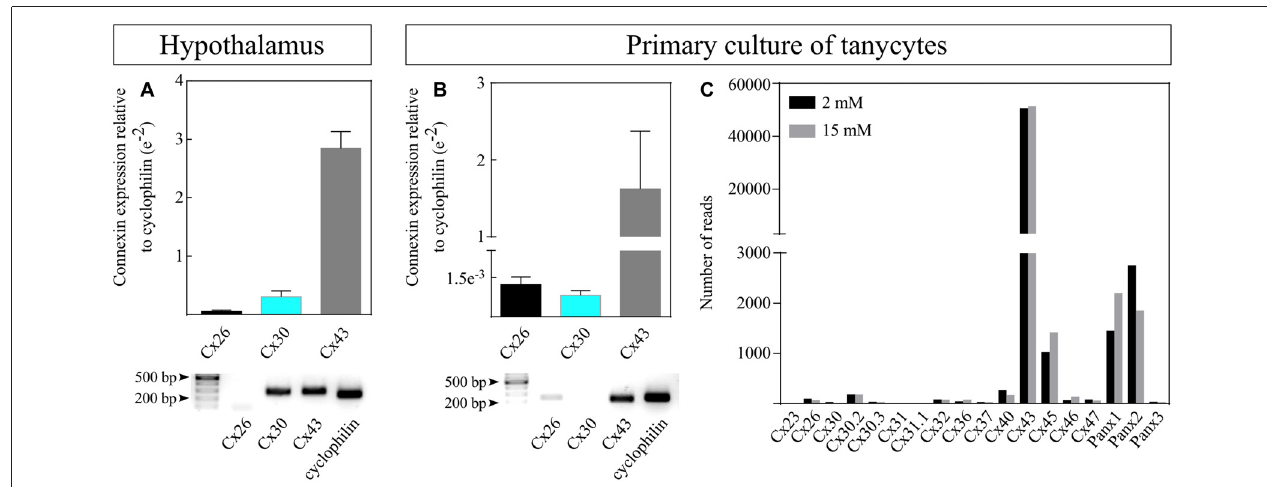
FIGURE 1 | Cx43 is the most abundant connexin expressed in rat tanycytes. Expression of connexin Cx26, Cx30 and Cx43 was measured by reverse transcription-quantitative polymerase chain reaction (RT-qPCR) in (A) whole rat hypothalamic tissues ( N = 3 animals) and (B) primary cultures of rat tanycytes (P1, N = 3 independent primary cultures). Transcriptional expression was normalized to the cyclophilin housekeeping gene. Representative electrophoresis of the RT-qPCR products is shown (bottom panels), although the blot for Cx30 was not detectable in the gel e = EXP. (C) Expression of connexins and pannexins (Px) obtained by RNAseq in primary cultures of rat tanycytes exposed to 2 and 15 mM